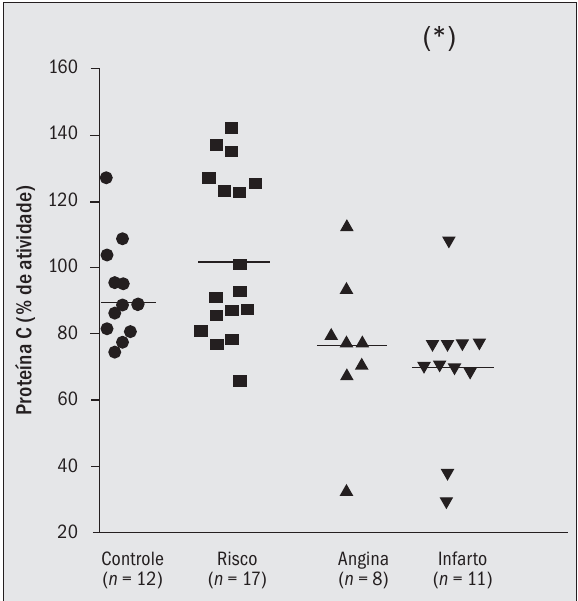
Figura 3 – Resultados das determinações das atividades da proteína C nos grupos estudados ( n = número de amostras). As barras horizontais indicam os valores médios obtidos para cada grupo. (*) Indica diferença significativa entre o grupo de risco e o grupo com infarto ( p < 0,05)